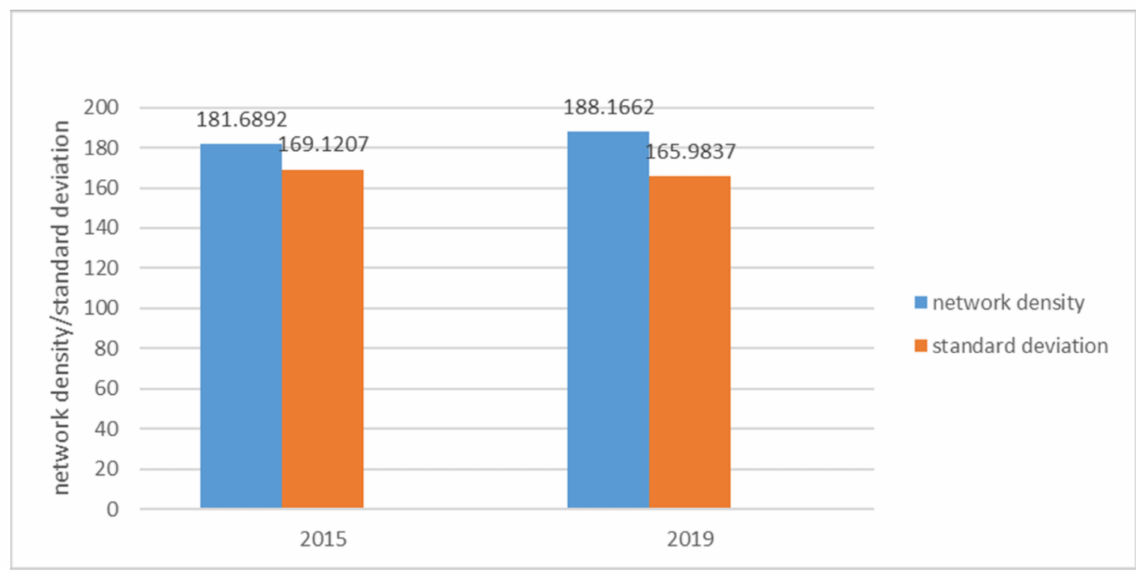
Figure 7. Network density